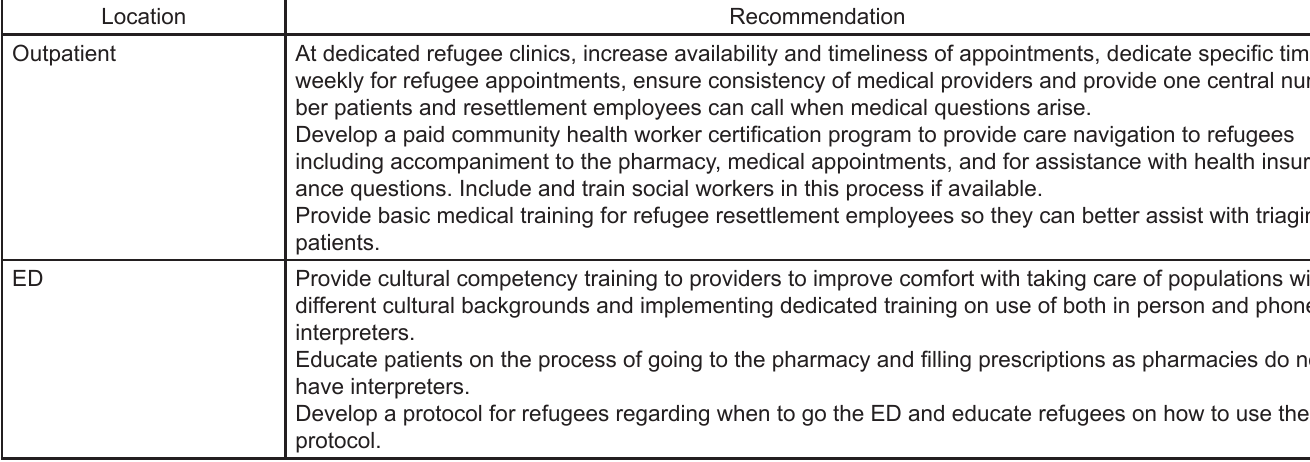
Table 2. Recommendations from Resettlement Employees.